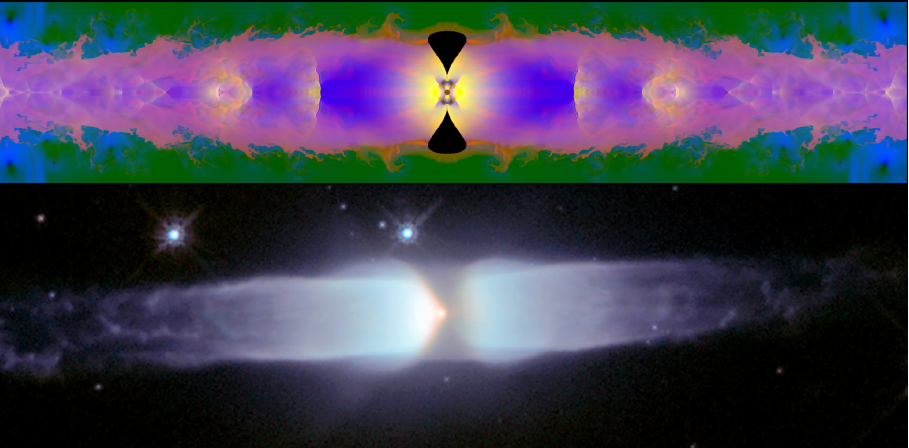
Figure 4. ( Top ): cross section snapshot at dimensionless time t = 6.0 of the simulation of an evaporating ring as in Equations (11) and (12) with r − = 0.15, r + = 1.0, b = 1.5, n = 2.5, γ = 1.2, M = 1.55 and L / L = 8.0. RGB colours correspond to ρ , P , and v . ( Bottom ): observation of the 0 0 cylindrical nebula Hen 3-401